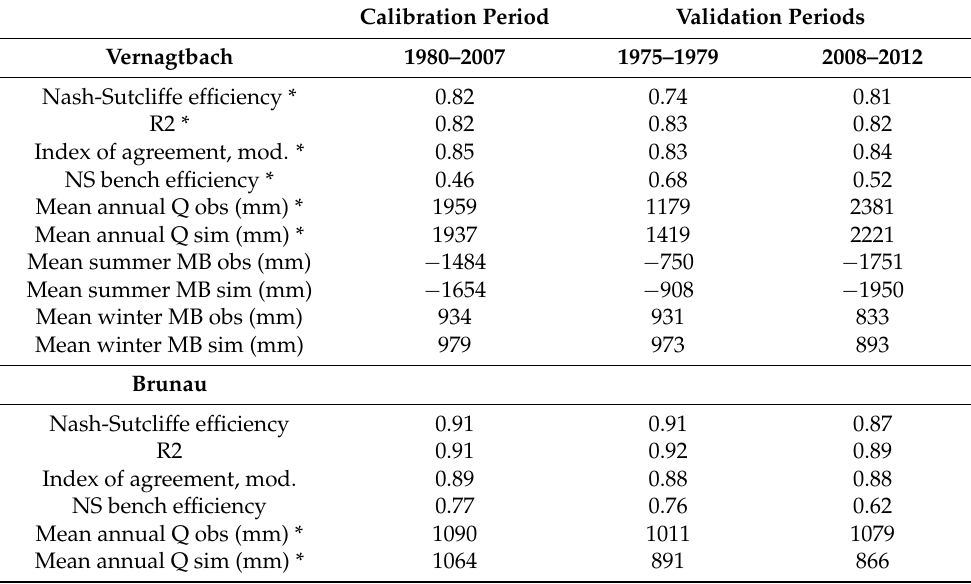
Table 3. Model efficiency, simulated and observed annual streamflow and glacier mass balances for the calibration and validation periods ( Q obs/sim = observed/simulated runoff; MB obs/sim = observed/simulated glacier mass balances).